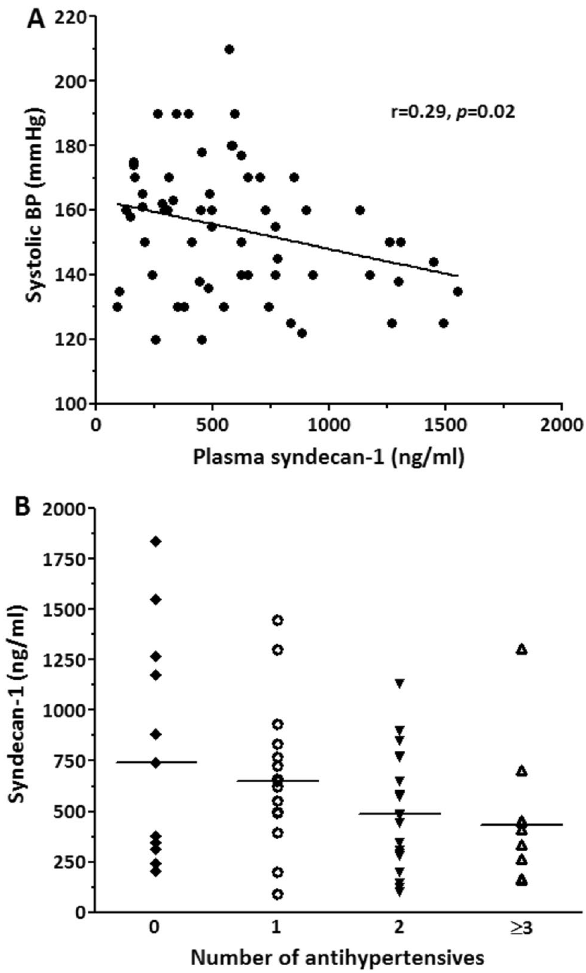
Figure 2. Soluble syndecan-1 levels in plasma are correlated with blood pressure and antihypertensive medication in women with preeclampsia. Correlation of soluble syndecan-1 with systolic blood pressure showing increasing blood pressure values with lower soluble syndecan-1, N = 59 ( A ). Soluble syndecan-1 among preeclamptic women categorized by number of received antihypertensive medication, from left to right: N = 11, N = 13, N = 16 and N = 7 ( B ). Median soluble syndecan-1 tends to decrease with increasing number of antihypertensives, but this was not statistically significant. Each symbol represents an individual patient with preeclampsia, the horizontal line represents the